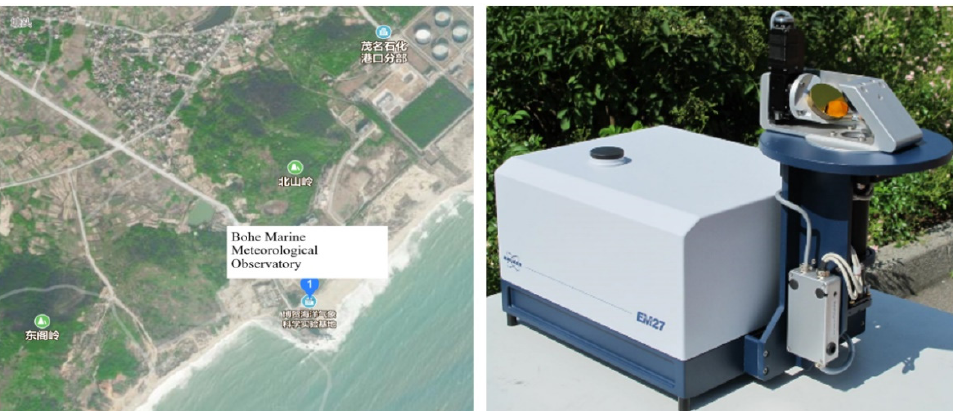
Figure 1. Observing site (Bohe Marine Meteorological Observatory, left ). FTIR spectrometer (EM27/SUN, right ).